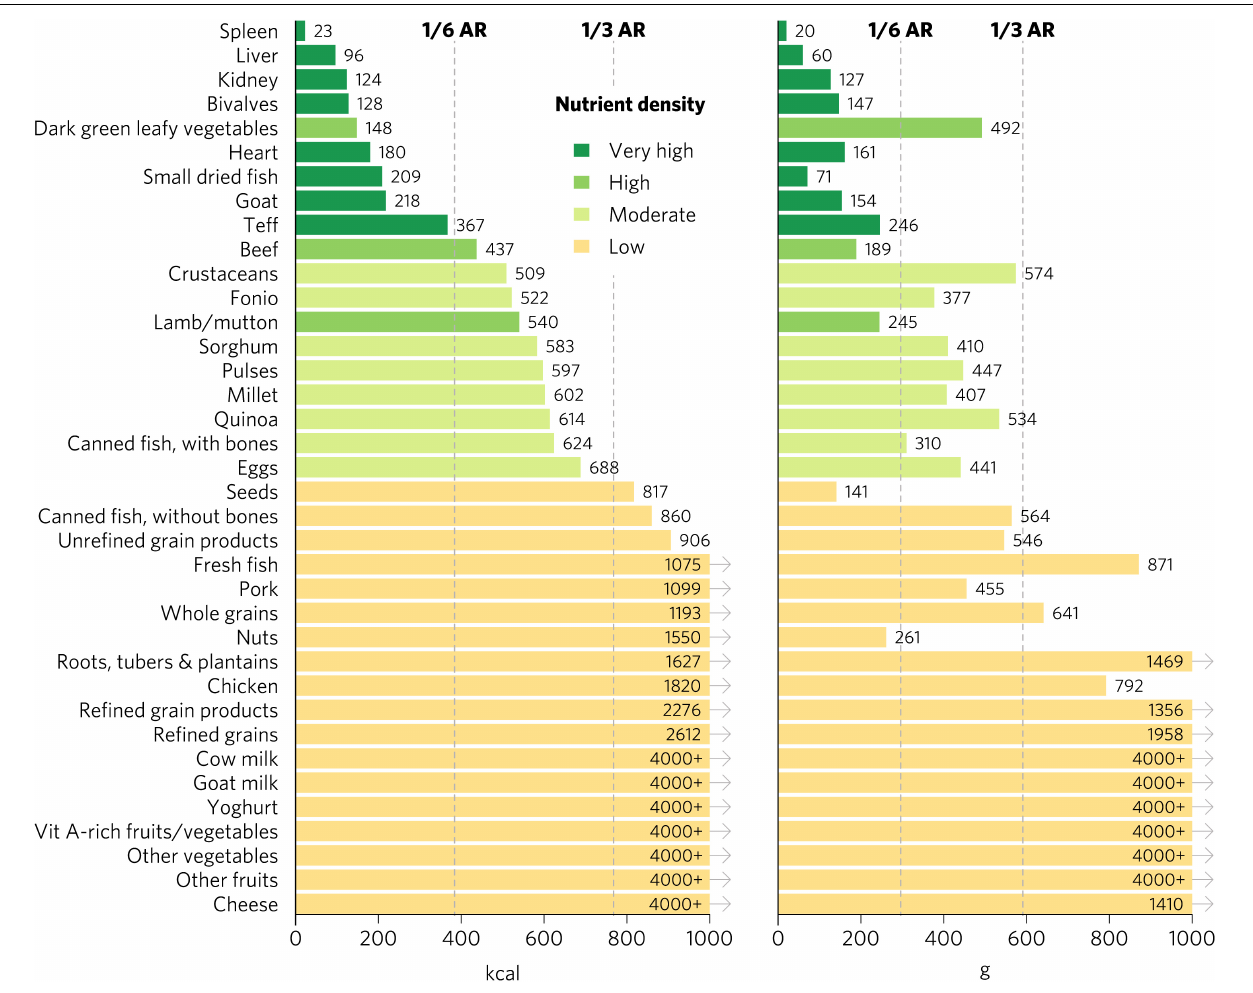
FIGURE 3 | Calories and grams needed to provide one-third of recommended iron intakes for women of reproductive age. Hypothetical average requirements for mass are based on an energy density of 1.3 kcal/g. AR, average requirement; Vit, vitamin.